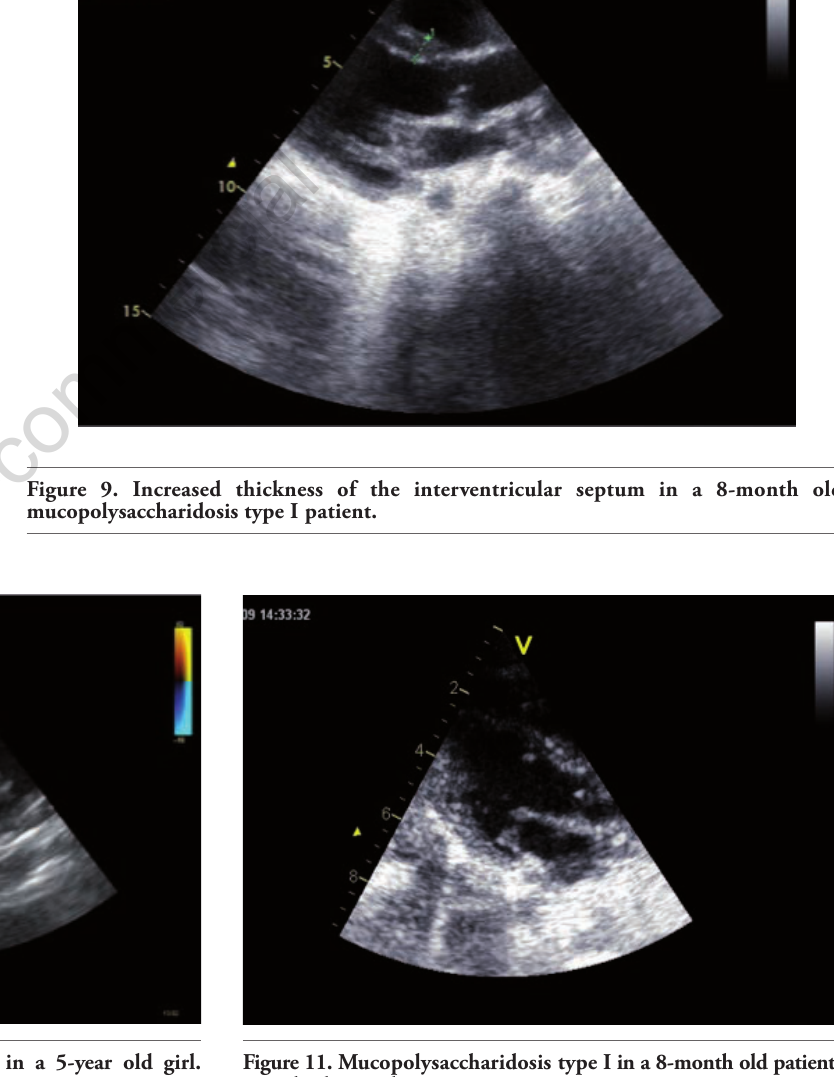
Figure 11. Mucopolysaccharidosis type I in a 8-month old patient. Mitral valve